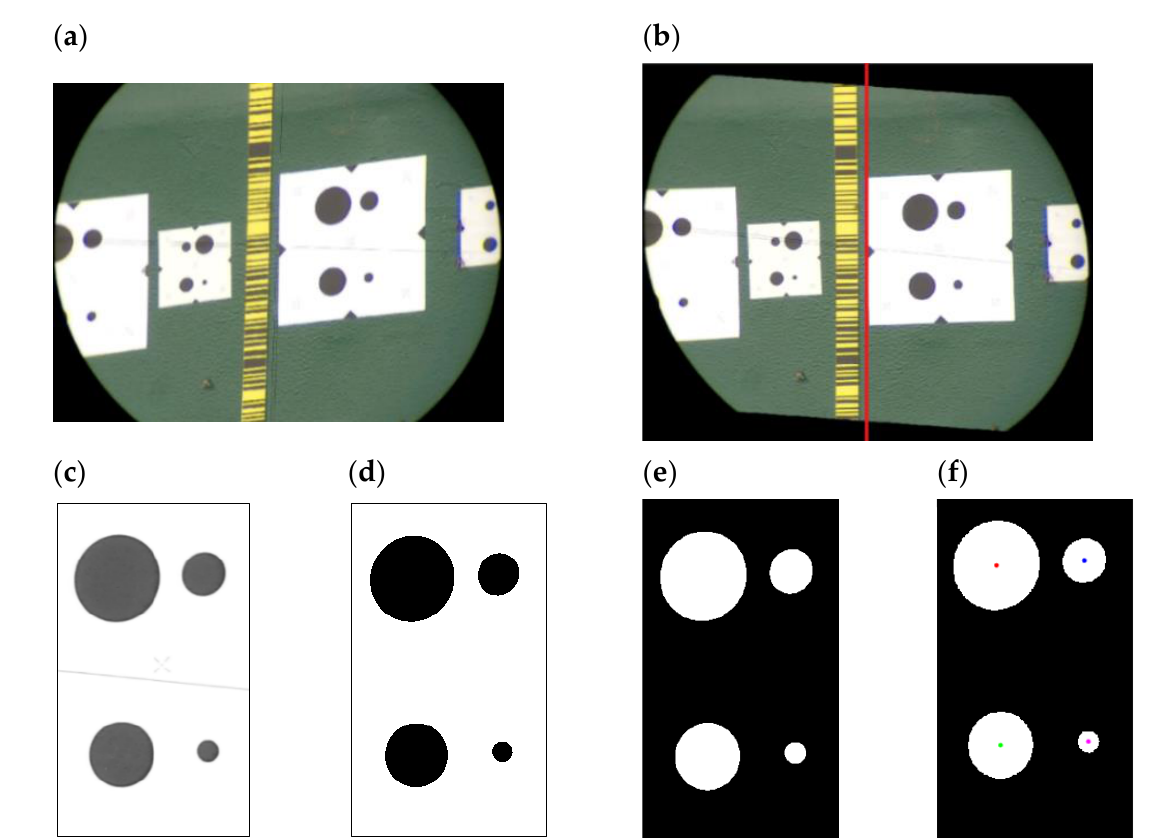
Figure 3. Representation of the photomark circle center detection workflow from video-extracted image frame ( a ), transformation to orthogonal projection ( b ), conversion to grayscale image ( c ), conversion to black and white image ( d ), inverting the black and white image ( e ), and circle detection ( f ).